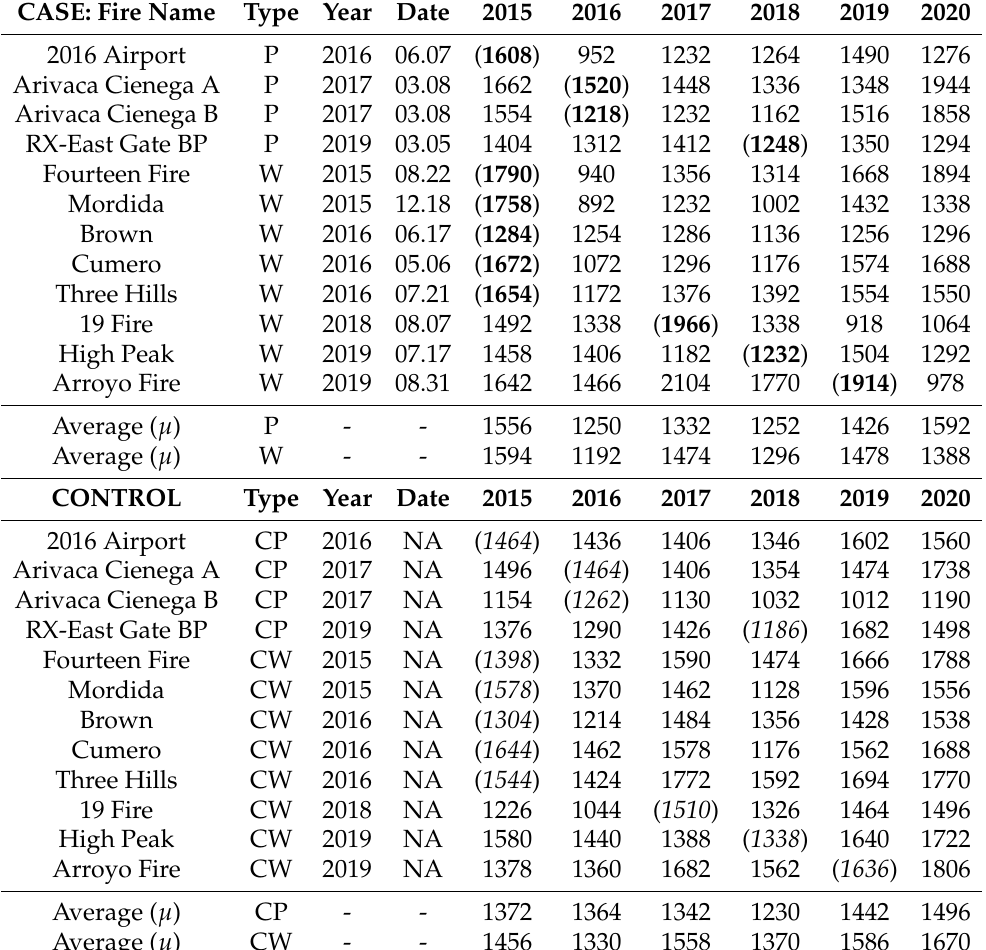
Table A1. The yearly estimated mean ( µ ) of fine-fuels (kg/ha) within burn perimeters for wildfire (W) and prescribed (P) fires at BANWR, with parenthesized boldface values indicating pre-burn estimates prior to ignition (some ignition dates do not align with calendar date but rather to pre- or post-imagery dates) against 1-km buffered control (C) areas around fire perimeters (parenthesized italicized values reference ignition time period for unburned control samples).